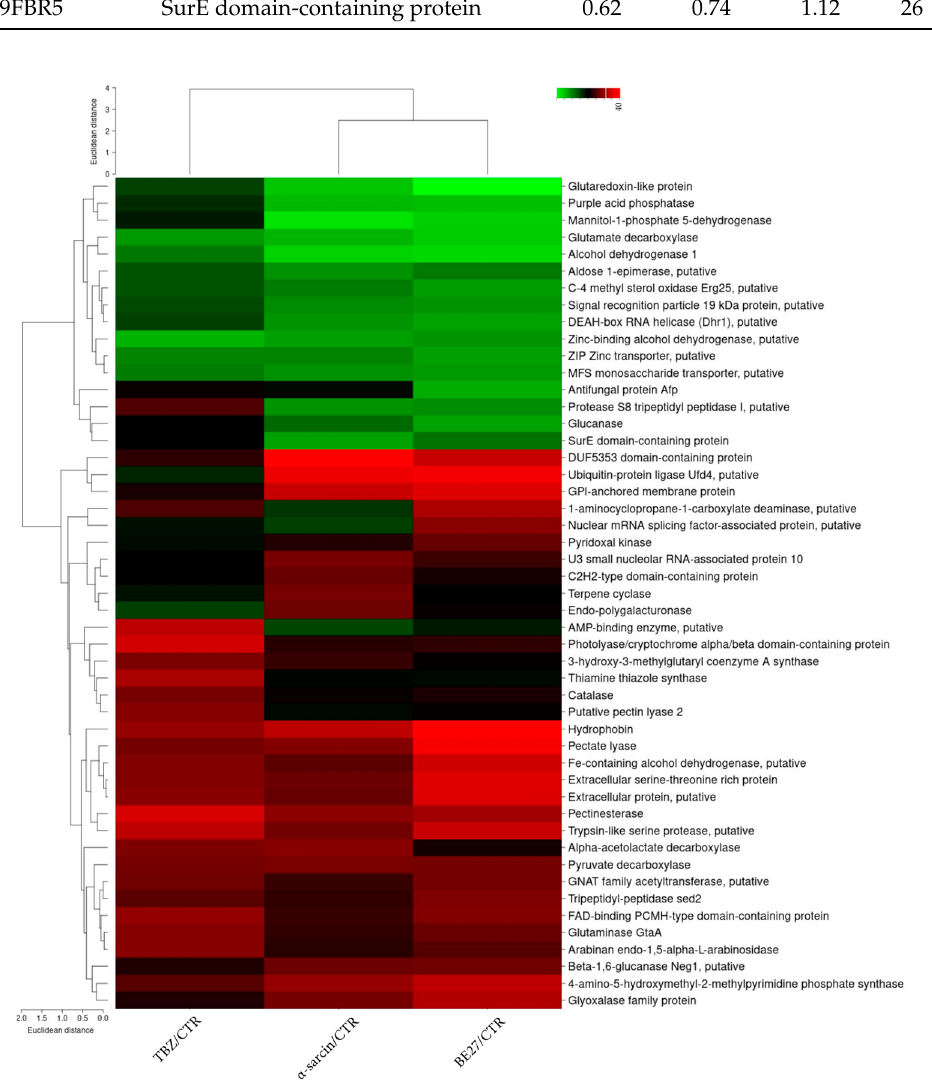
Figure 3. Heatmap representing the log2 fold-change values of differentially expressed proteins in α -sarcin, BE27- and TBZ-treated vs. untreated (CTR) P. digitatum samples. Down-regulated and up-regulated proteins are coloured in green and red, respectively.